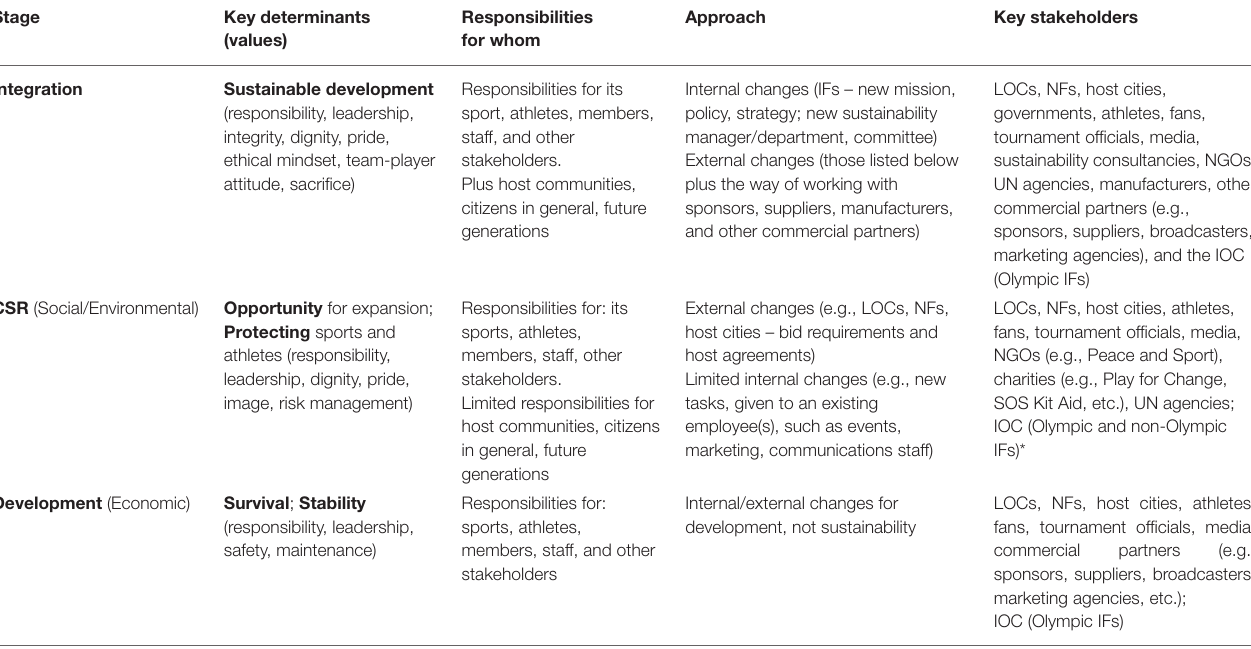
TABLE 4 | The sustainability ladder.